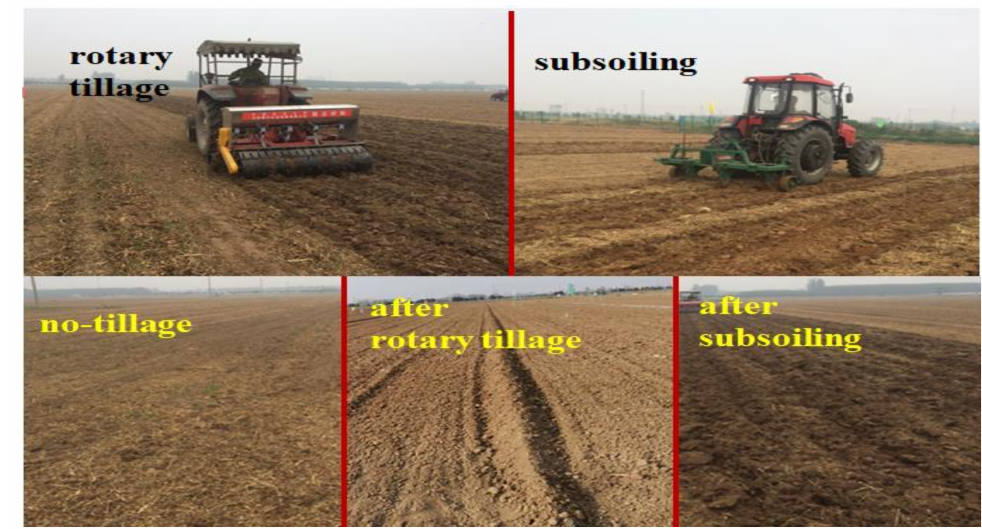
Figure 2. Different tillage treatments before winter wheat